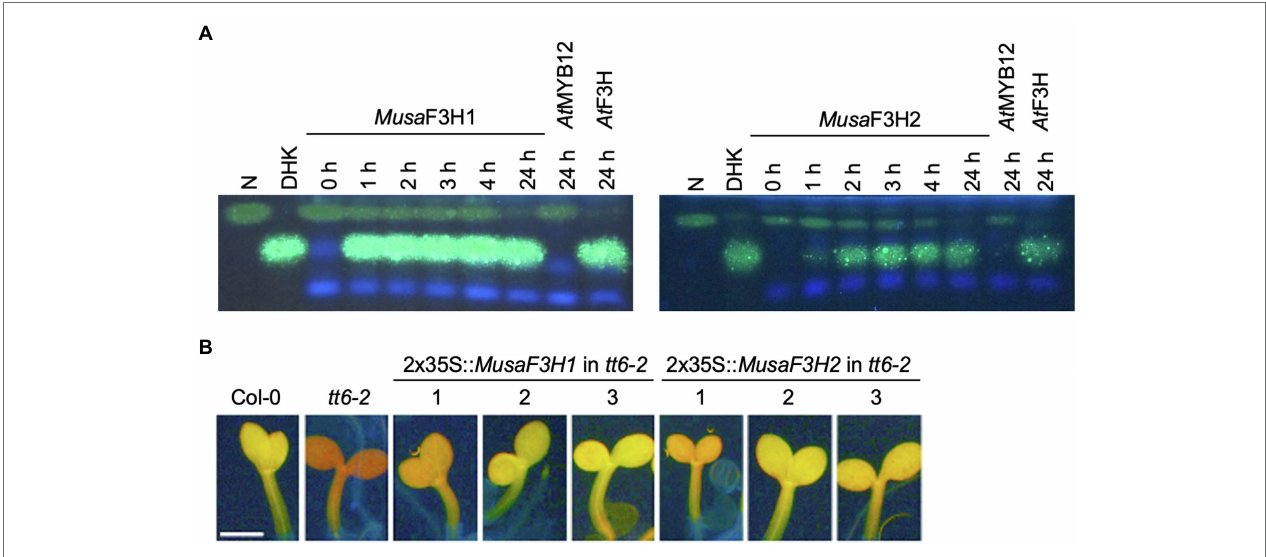
FIGURE 3 | Musa F3H1 and Musa F3H2 are functional F3Hs. (A) HPTLC analysis of F3H bioconversion assays using extracts from Escherichia coli expressing recombinant Musa F3H1 or Musa F3H2. The substrate naringenin (N) and the product dihydrokaempferol (DHK) were used as standards. At F3H was used as a positive control. At MYB12 was used as a negative control. (B) Analysis of tt6-2 mutant seedlings complemented with Musa F3H1 and Musa F3H2. Col-0 wild type and tt6-2 were used as controls. Representative pictures of DPBA-stained seedlings under UV light are given. Yellow fluorescence indicates flavonol glycoside accumulation. The different numbers indicate individual transgenic lines. The scale bar indicates 0.5